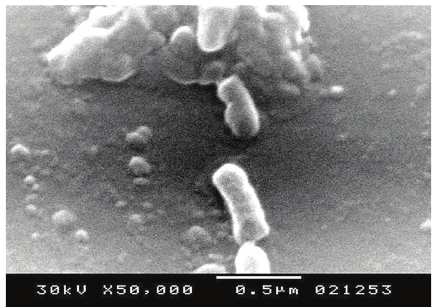
Figure 5: Light microscope for the STGs. The cells show correct 3D structure.